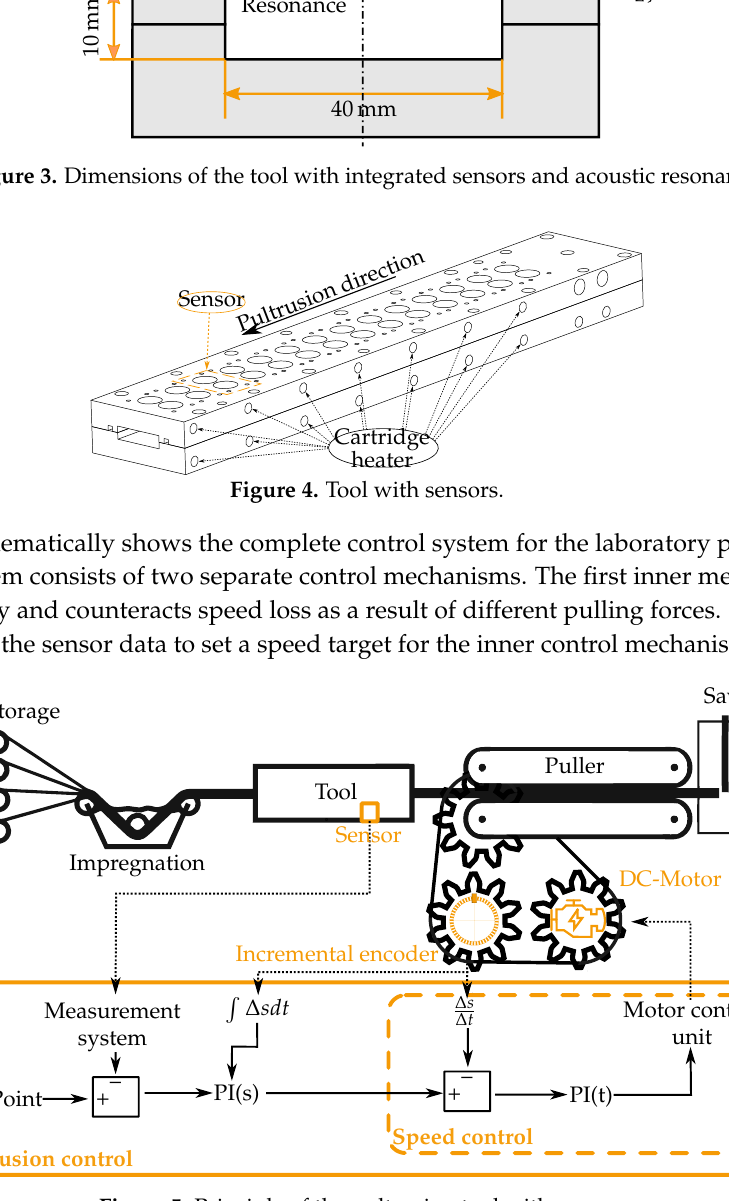
Figure 5. Principle of the pultrusion tool with